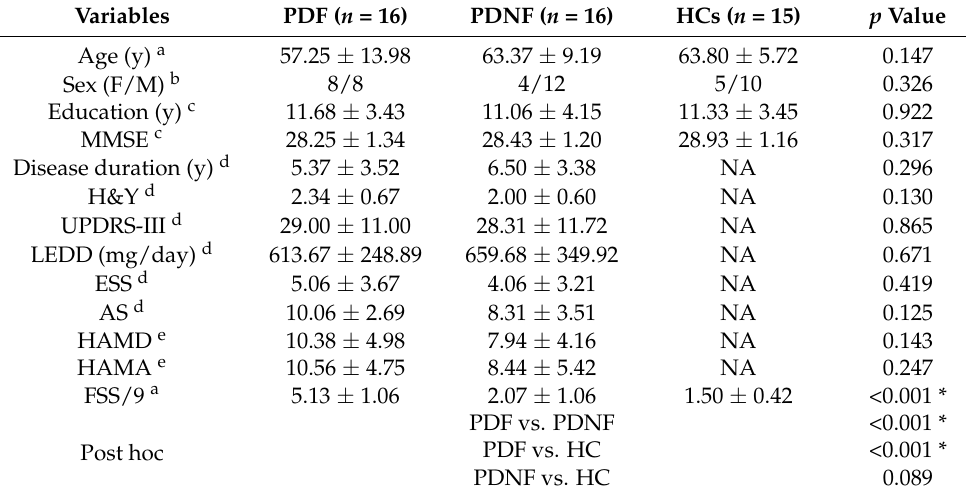
Table 1. Demographic and clinical characteristics of all